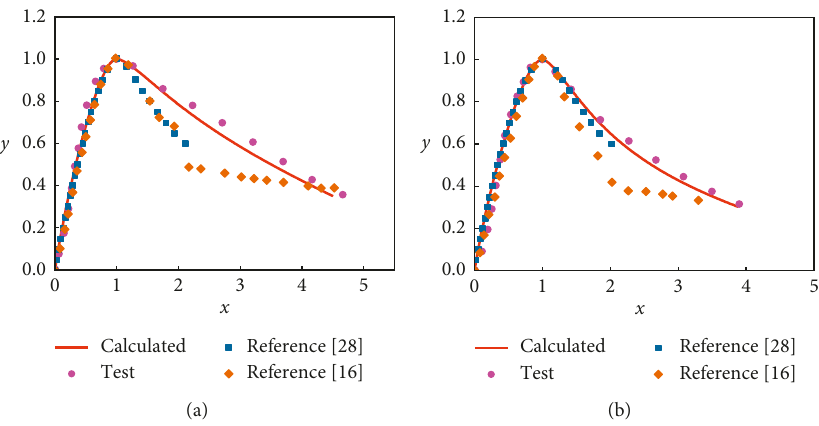
Figure 16: Verification of the proposed model under monotonic loading. (a) r � 50%. (b) r � 100%.